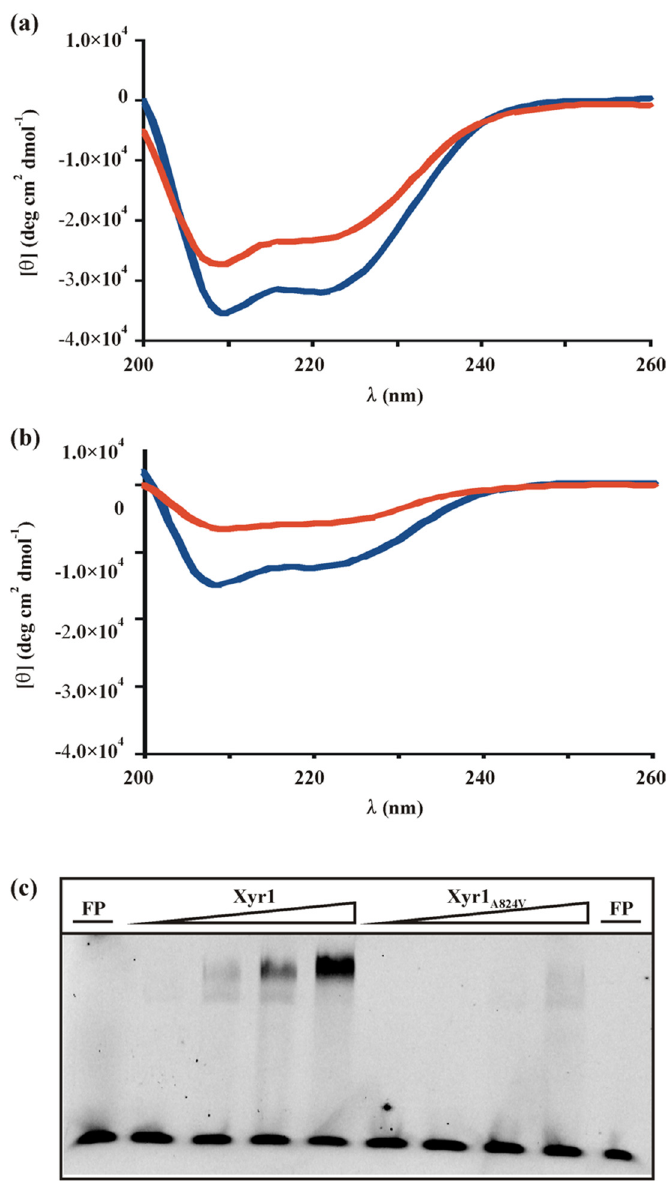
Figure 2. Analyses of Xyr1 and Xyr1 A824V binding to target DNA. Far-UV spectra (200–260 nm) of a CD spectroscopy analysis of Xyr1 ( a ) or Xyr1 A824V ( b ) alone (blue lines) and their respective protein– DNA complexes (red lines) using a xyn1 URR fragment ( − 430 to − 396 bp from ATG) in a molar ratio of 1:1. Data were plotted after correction for the contribution of the DNA. ( c ) EMSA analysis of Xyr1 and Xyr1 A824V DNA-binding behaviour using increasing amounts of protein (170 ng, 340 ng, 680 ng, and 1360 ng, respectively) and a fluorescently labelled xyn1 URR fragment. FP, free probe.